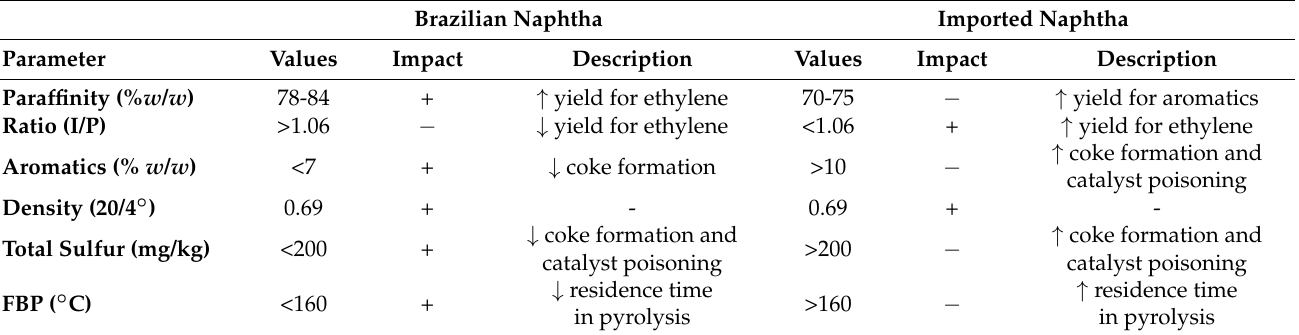
Figure 7. Average distillation curve values for the naphtha samples. Table 7. Comparison between naphtha